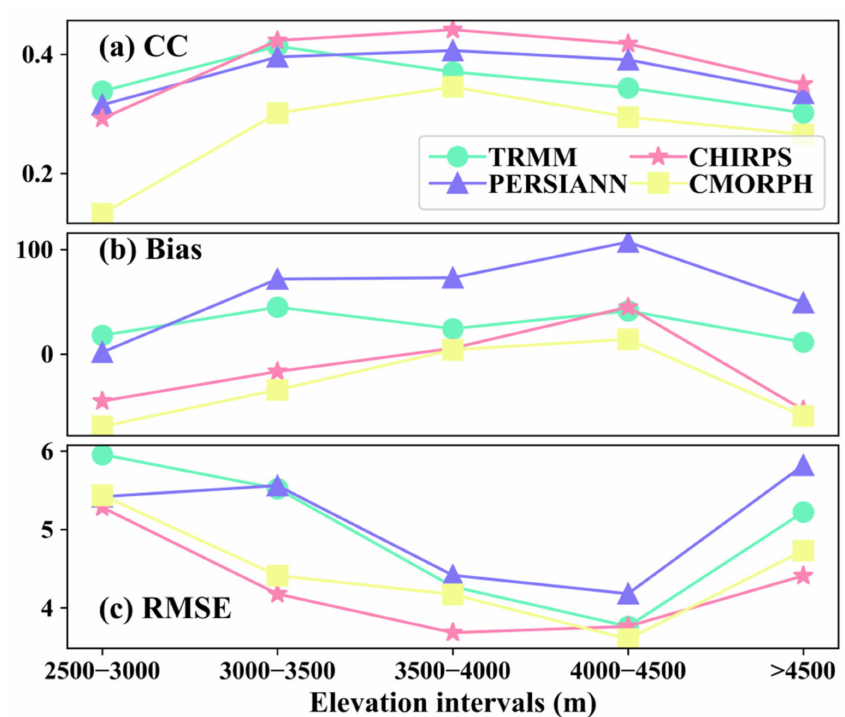
Figure 10. The line chart of the evaluation metrics calculated by daily precipitation for the four products at five altitude intervals: ( a ) CC, ( b ) Bias, ( c ) RMSE.